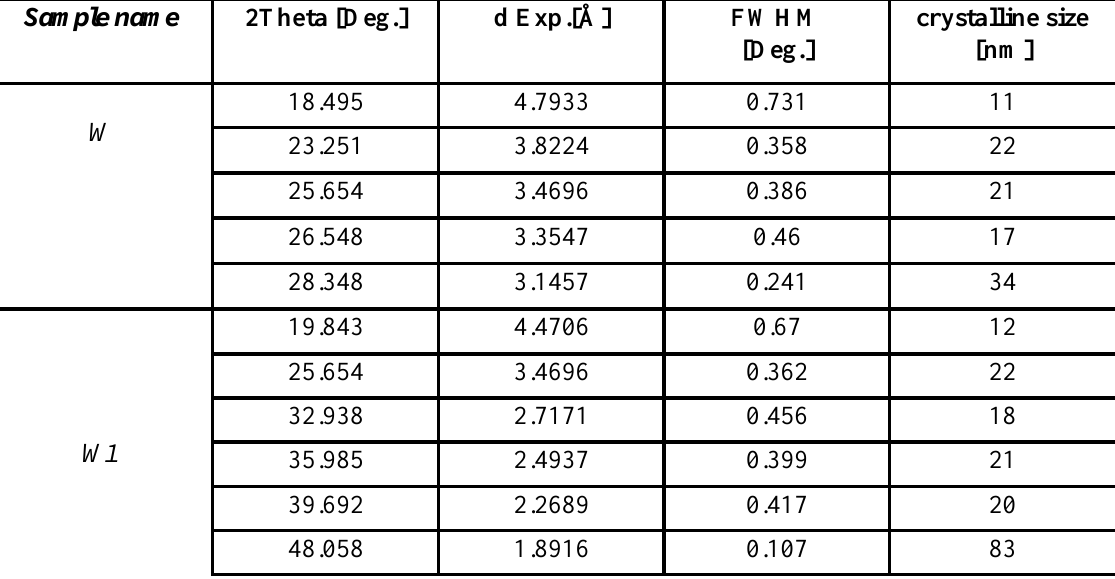
Table 4: The values of (0θ) of the strong peaks of the pure PANI with water based